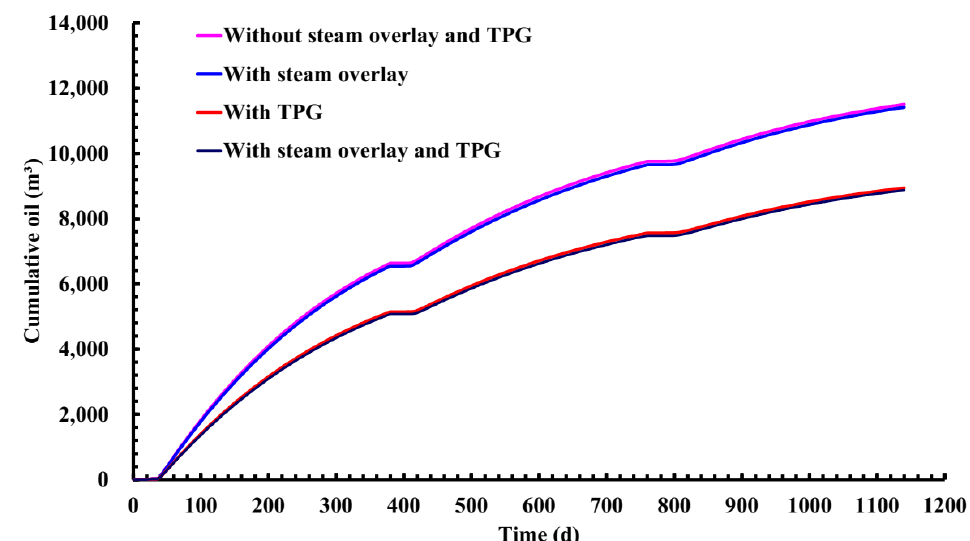
Figure 11. The effect of the steam overlay and TPG on the cumulative oil production.